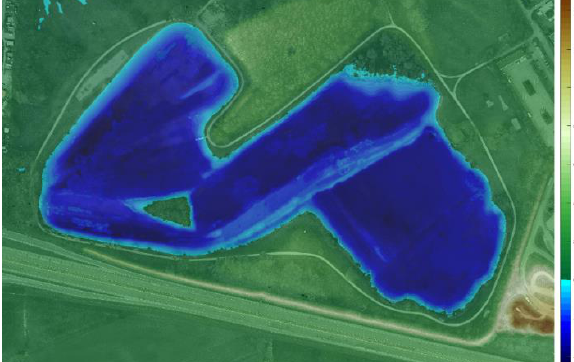
Figure 7. Interpolated DEM from laser scanner data.